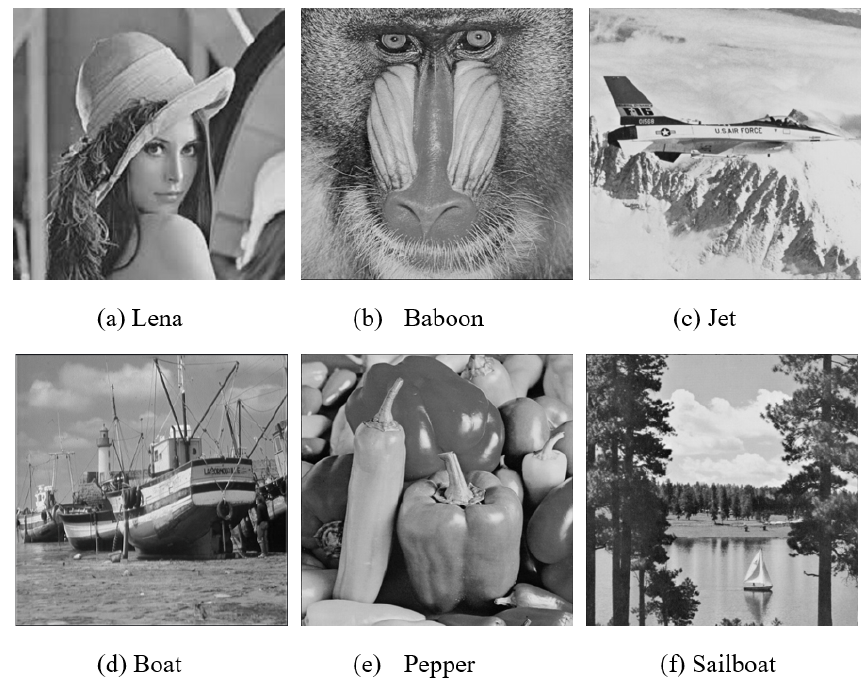
Figure 13. Test images.